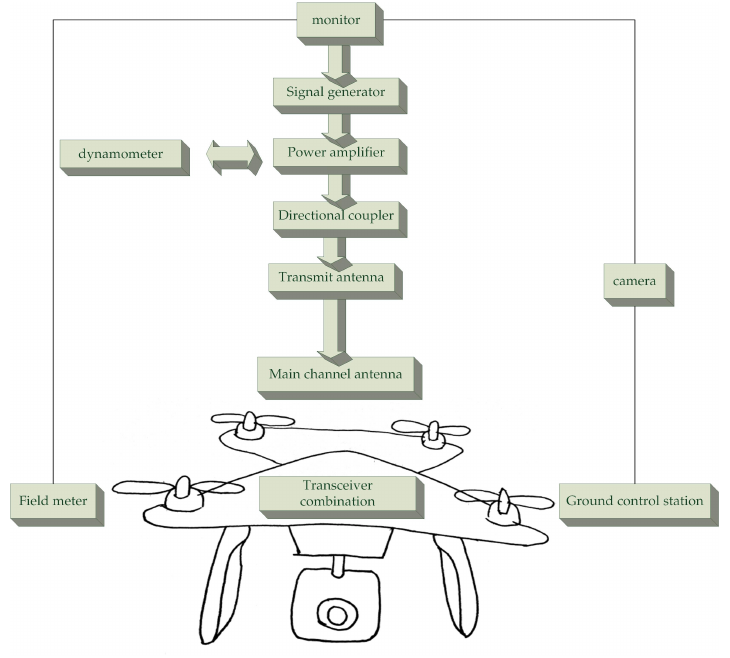
Figure 3. Continuous wave electromagnetic radiation effect test system for UAV. Table 2. Modules and functions of UAV continuous wave electromagnetic radiation effect test